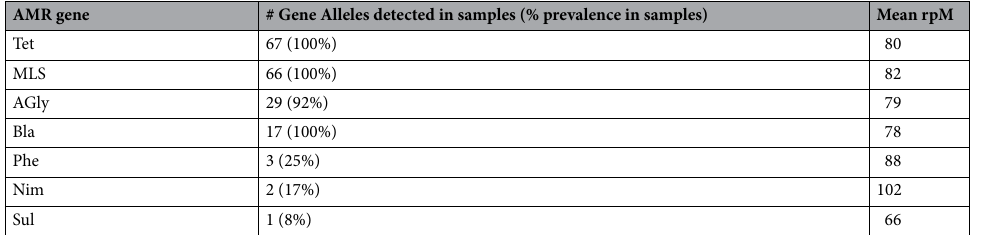
Table 1. Antimicrobial resistance genes detected in 9 slurry samples and 3 environmental samples. AMR antimicrobial resistance, rpM reads per million mapped reads, tet tetracycline, MLS macrolide, lincosamide, streptogramin, AGly aminoglycoside, Bla beta-lactamas, Phe phenicol, Nim nitromidazole, Sul